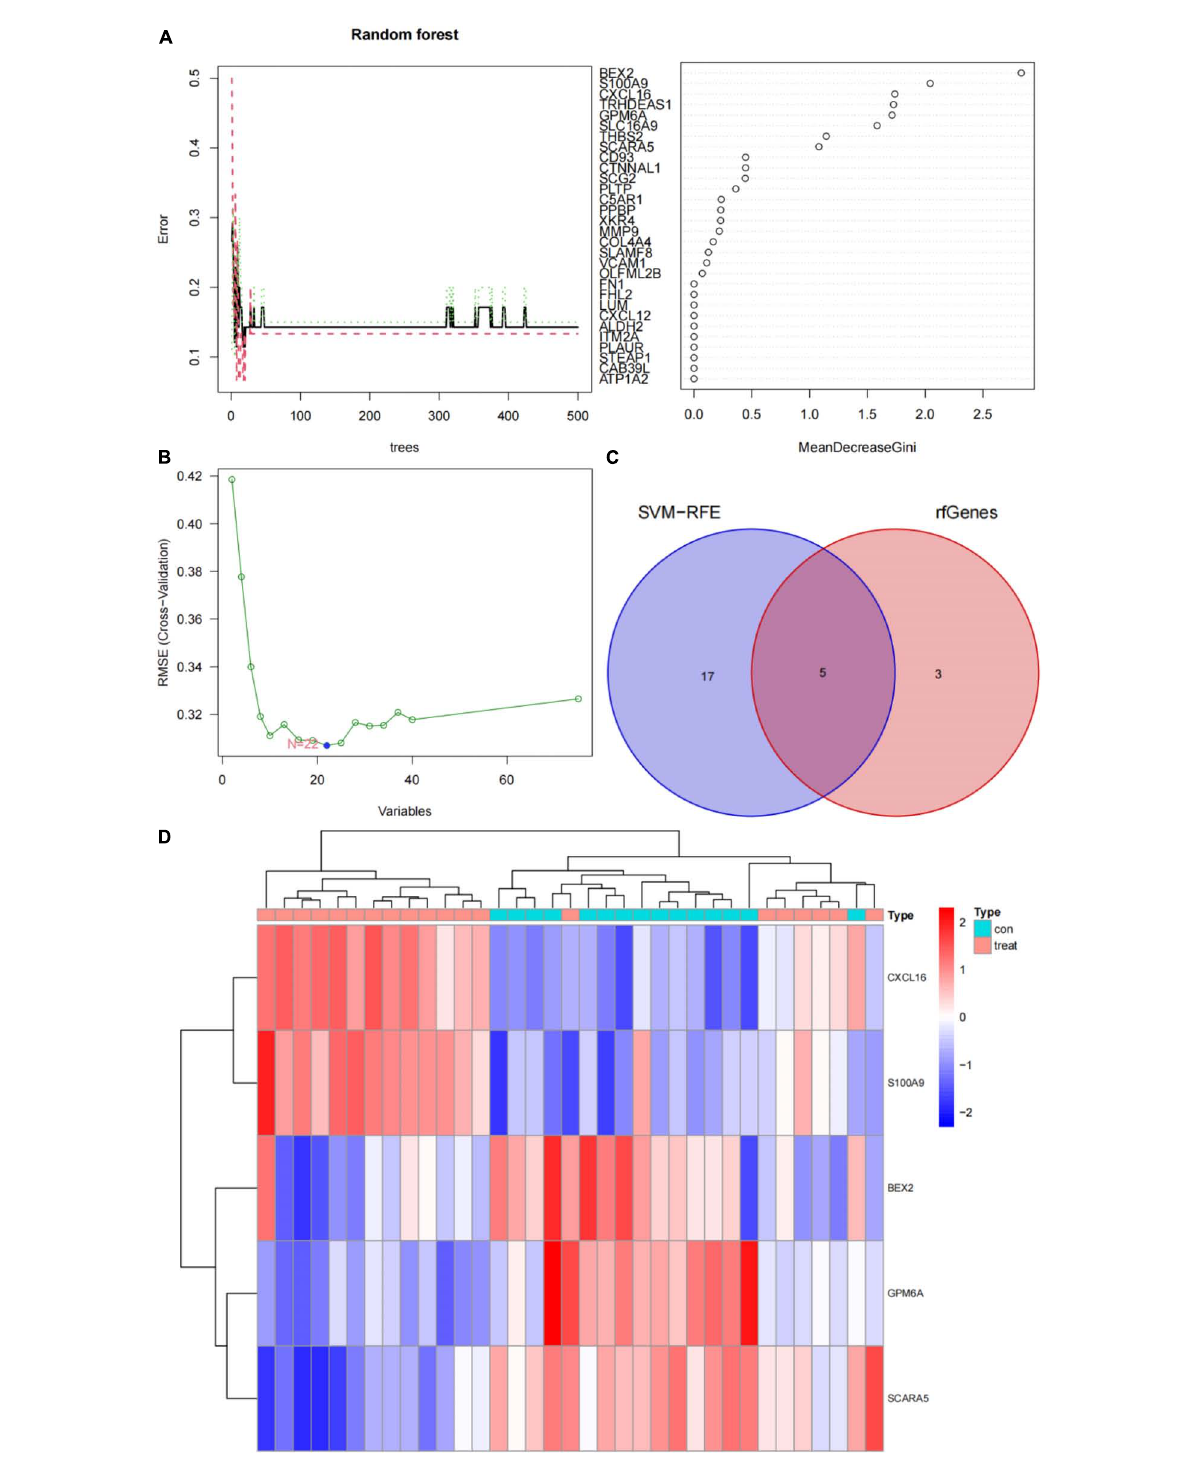
FIGURE5 Screening for diagnostic markers using a comprehensive technique and five markers were heat mapped in AVC and normal samples. (A) Random forest (RF) algorithm to screen for diagnostic markers. (B) Support vector machine-recursive feature elimination (SVM-RFE) algorithm to screen for diagnostic markers. (C) Venn diagram illustrating the intersection of diagnostic markers acquired using two methods. (D) Each row corresponds to a single sample, whereas each column corresponds to a particular gene. The red color denotes AVC samples, while the blue hue denotes normal samples. The color scale indicates the relative degree of gene expression in a particular slide: Blue denotes low levels of relative expression, while red shows high levels of relative